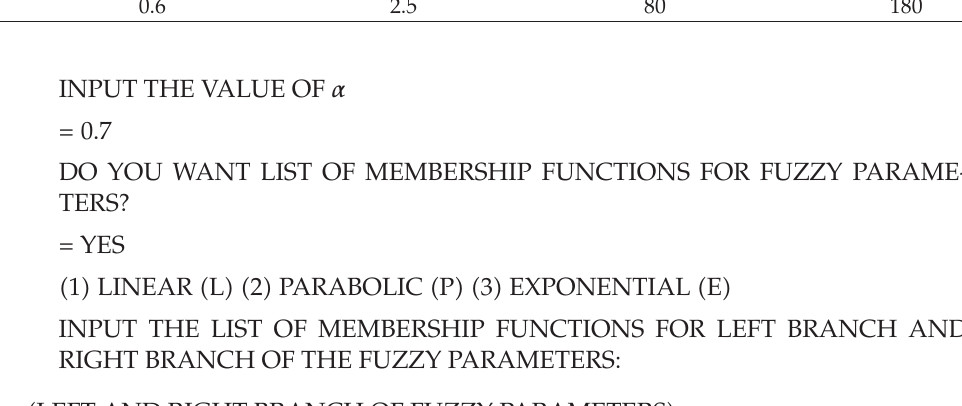
Table 2: Boundary level of decision variables (cid:2) C